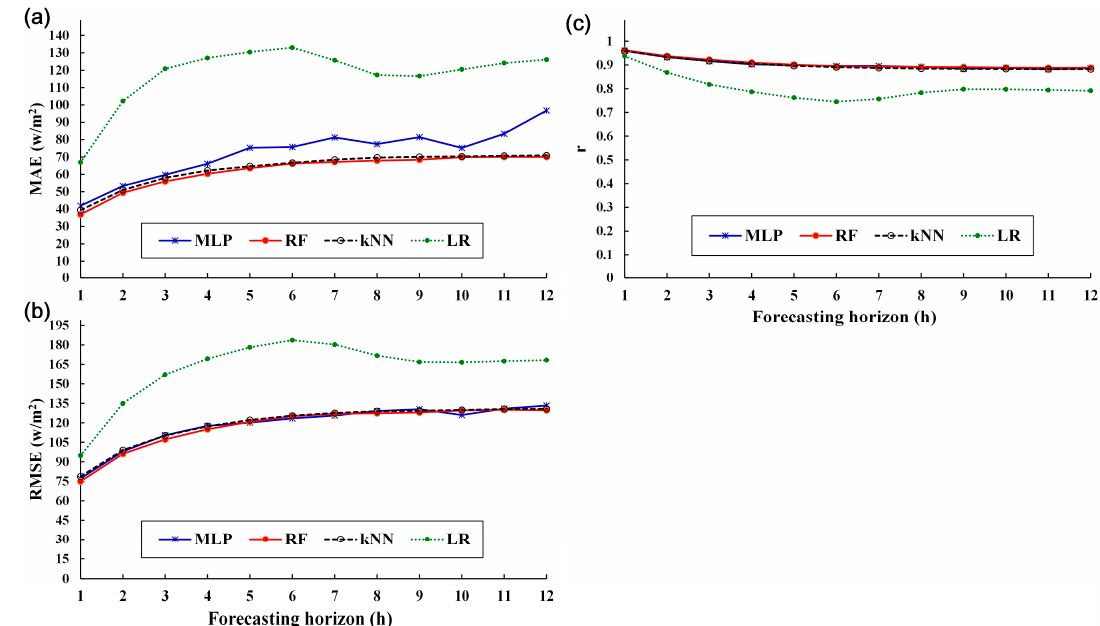
Figure 7. Prediction errors by all models over a 12-h forecast horizon in the year 2016: ( a ) MAE, ( b ) RMSE, and ( c ) r.